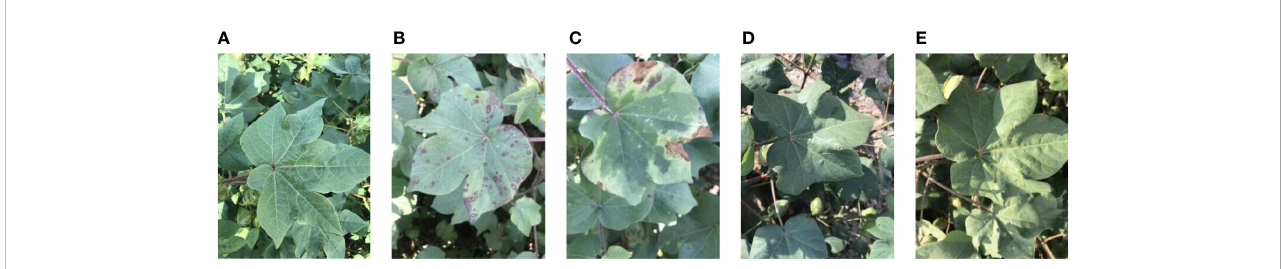
FIGURE 2 Images of the Cotton Leaf dataset. The dataset is divided into fi ve representative leaves: (A) a normal cotton leaf, (B) a cotton leaf with spotted lesions, (C) a cotton leaf with regional lesions, (D) a cotton leaf with occluded blades, and (E) a cotton leaf with uneven